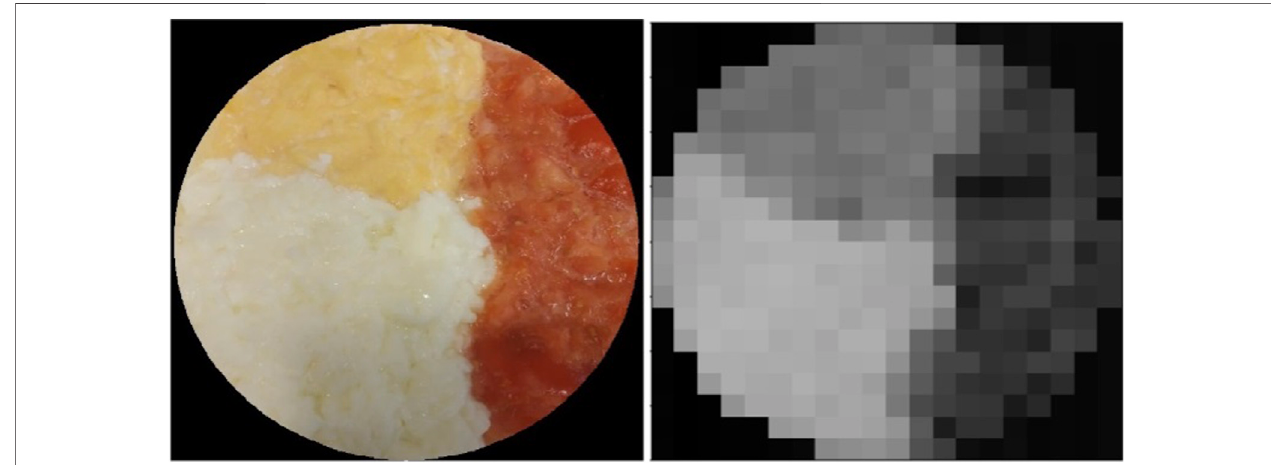
FIGURE3| Trivialmeal(left)anditistastemap(right)producedwithasalinitysensor.Themealismadeoutofunsaltedscrambledeggs,scrambledeggwhites,and blended tomatoes, placed separately.